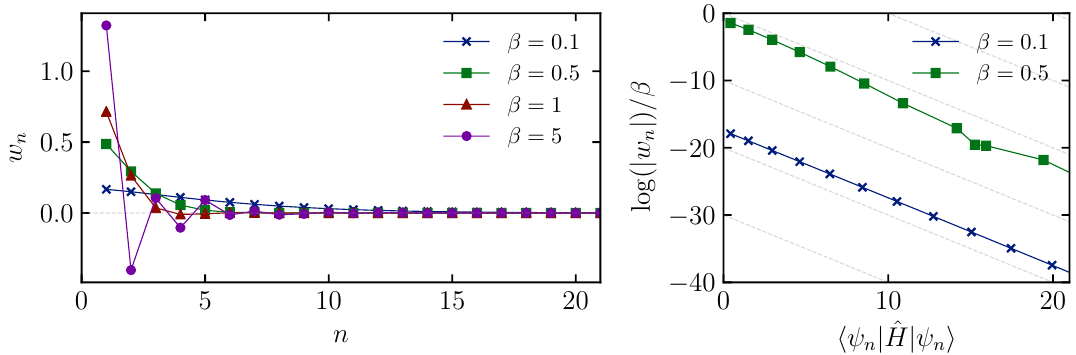
for the classical Gibbs ensemble Figure 3: Distribution of quasiprobabilities w n for the quartic potential at four different temperatures. The left plot shows the ) at four values of β , where negative probabilities arise at eigenvalues of W ( x , x 1 2 | ) /β as function of E = 〈 ψ | ˆ H | ψ 〉 for the larger β . The right plot shows log ( | w n n n n two smaller values of β . The parameters are the same as in Fig.